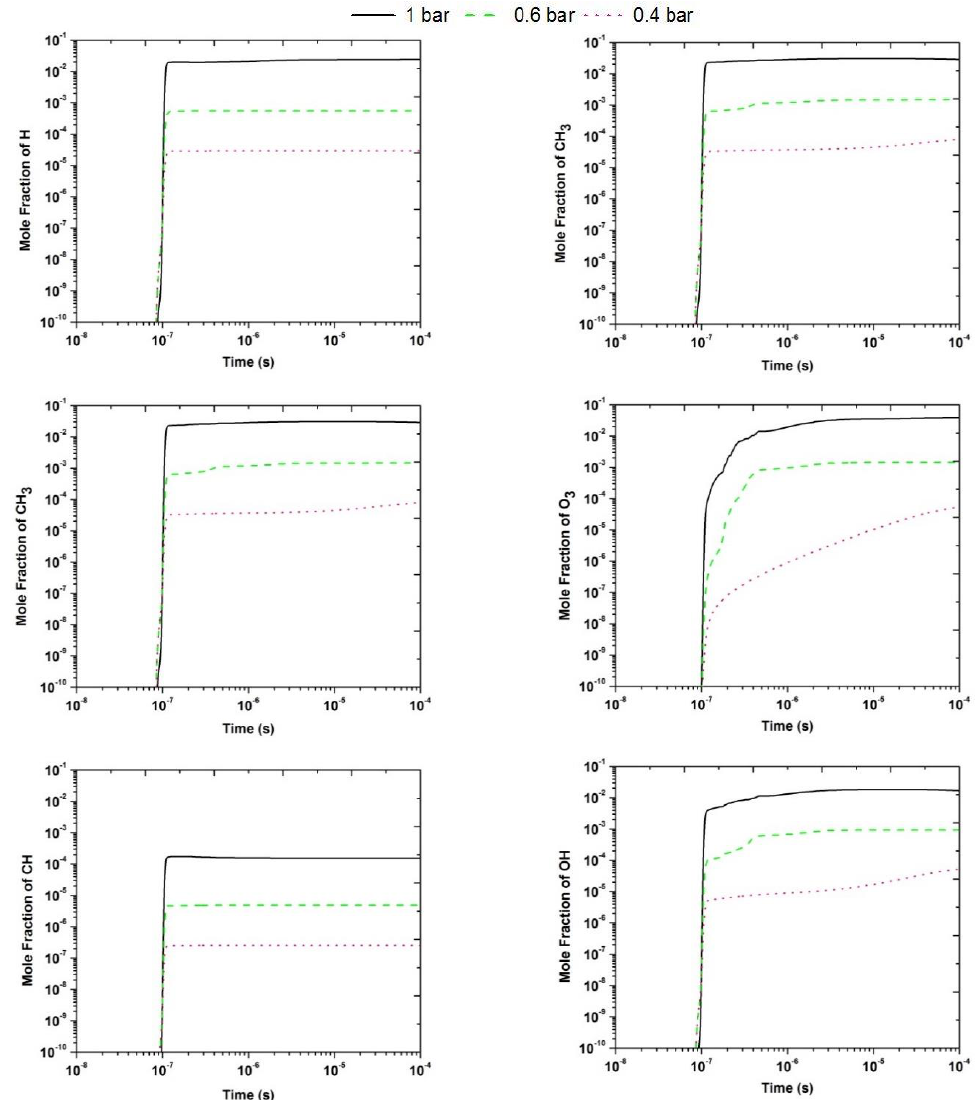
Figure 11. Neutral radicals produced due to plasma actuation at three different inlet pressures.